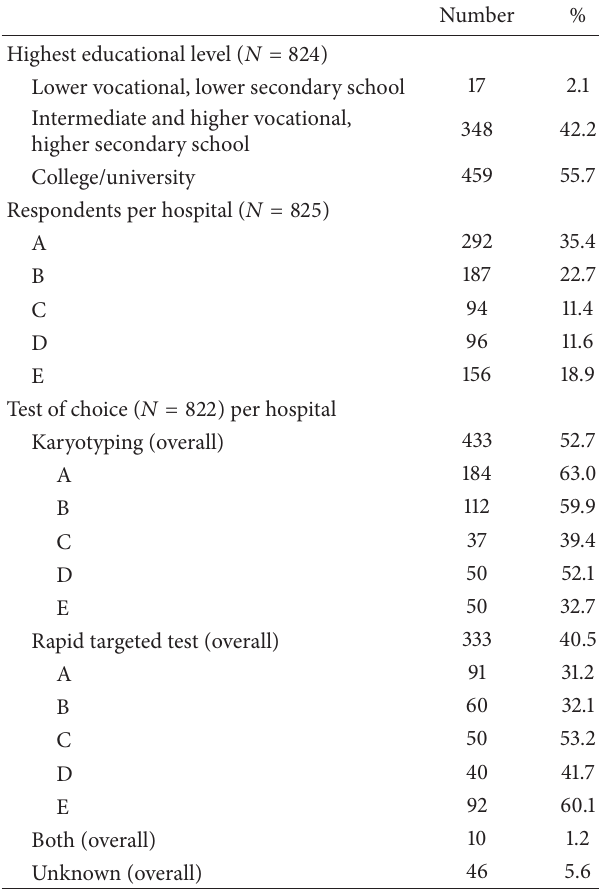
Table 1: Personal characteristics of the 825